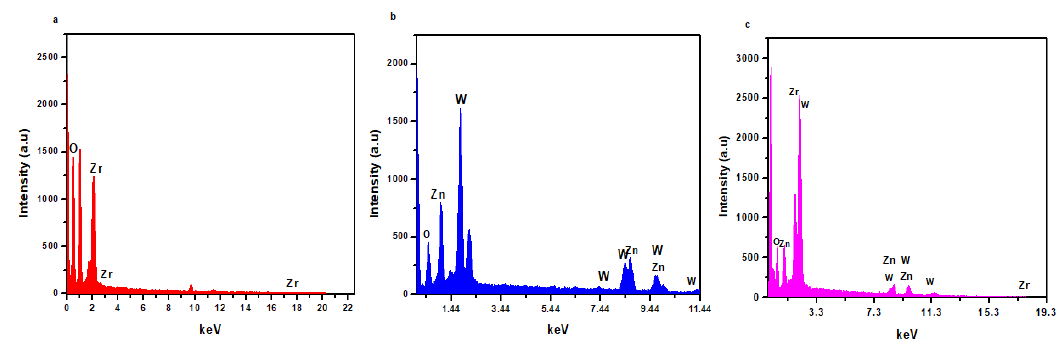
Fig.5. (a) EDX of ZrO